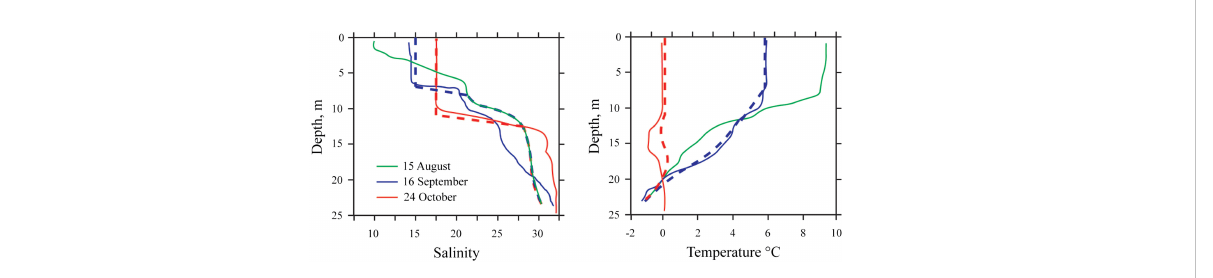
FIGURE 9 Vertical salinity (left) and temperature (right) structure in the central part of the Ob-Yenisei plume in the middle of August (green line), middle of September (blue lines), and late October (red lines) according to in situ measurements (solid lines) and numerical modeling (dashed lines). Location of the in situ measurements is shown by the left white arrow in Figure 8.